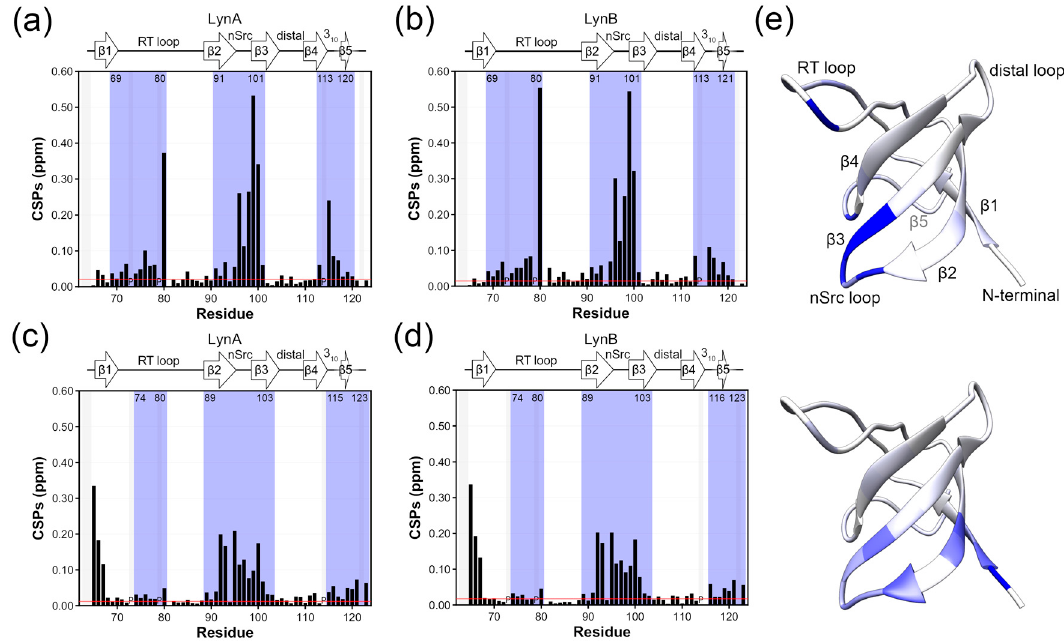
Figure 5. 1 H- 15 N combined chemical shift perturbations (CSPs) in the SH3 domain observed: ( a , b ) before and after the addition of 1 equivalent of VSL12 peptide to ( a ) LynA ( b ) LynB USH3 construct; ( c , d ) between the SH3 domain of LynA and LynB USH3 and the isolated Lyn SH3 domain, both in the presence of 1 equivalent of VSL12 peptide. The blue shade identifies relevant continuous perturbed regions as defined in the text based on the threshold calculated as the average plus 5 standard deviations from the 10% least affected residues. The letter “P” identifies proline residues. ( e ) CSP values are mapped on the structure of Lyn SH3 (PDB 1W1F) in a blue scale ranging from 0 (white) to 0.3 (intense blue) ppm obtained ( top ) in panel ( a ) ( bottom ) in panel ( c ). The numbering used for LynB is the same as for LynA.